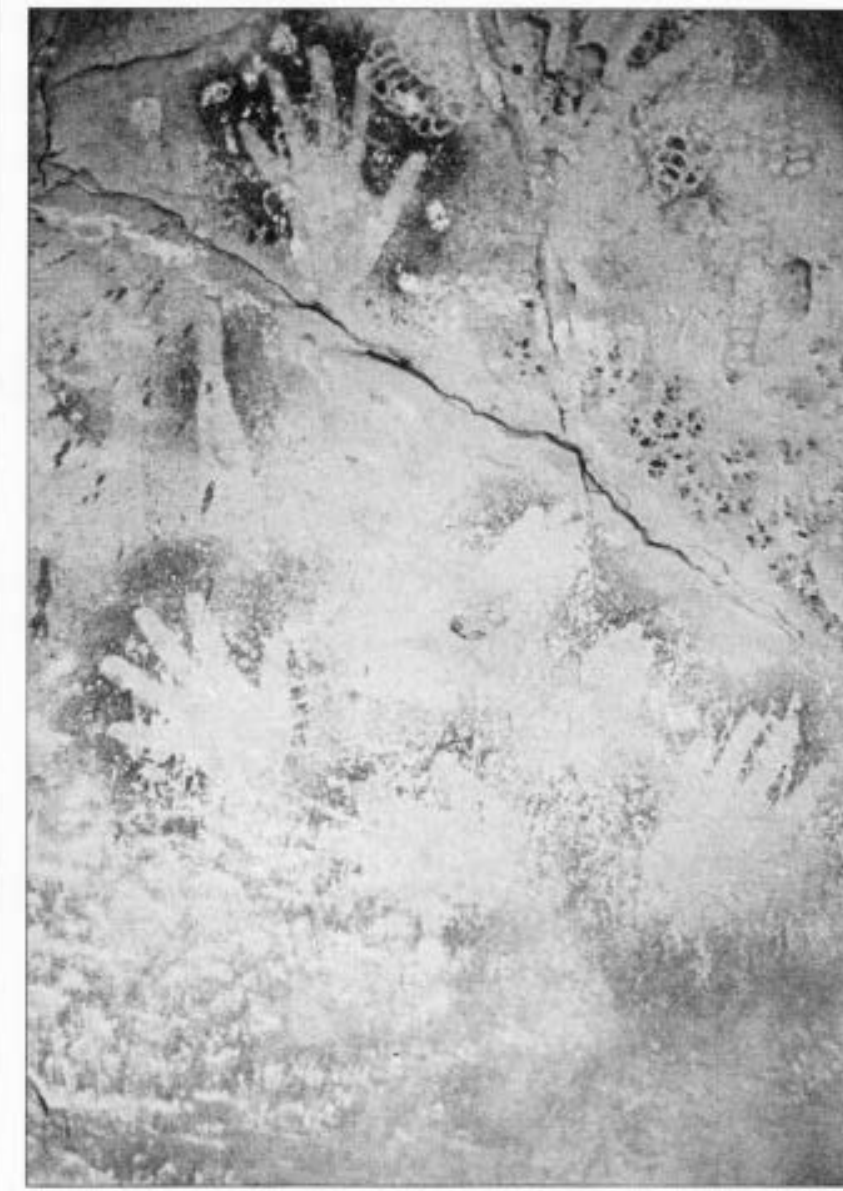
Figure 8 Handprints on a wall in the rear chamber of the El Obyeiyid cavern, which is one of only three in Egypt to reveal prehistoric rock